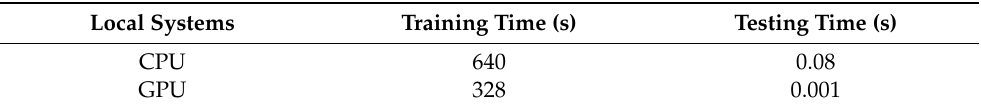
Table 7. Execution time of the proposed model using the solar